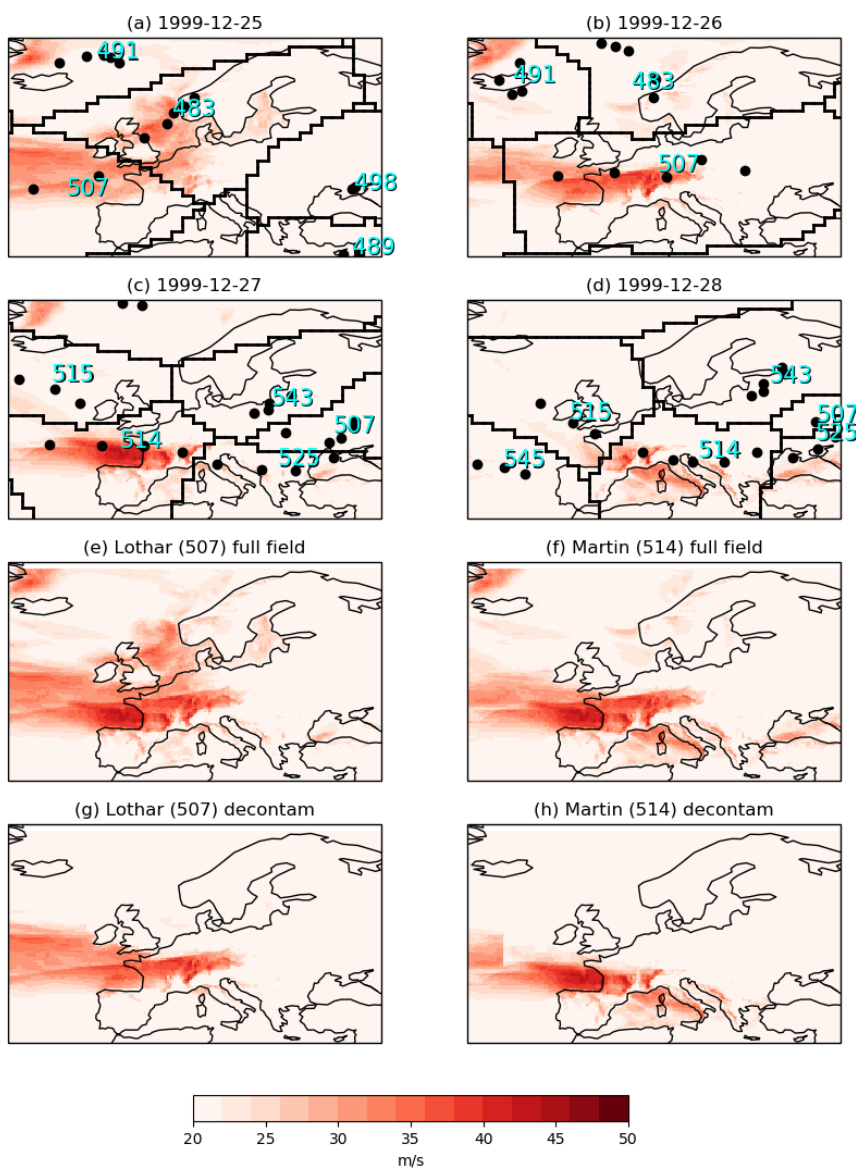
Figure 2. Storm separation method: panels (a–d) show the daily maximum gust fields from ERA5 for 25–28 December 1999, with the 6-hourly track points of each storm identified in the domain on that day (the cyan number gives the track identification number). The thick black lines mark the shape of the mask used for each track on each day; for example, the footprint of Lothar (track 507) is made by taking the maximum of the gusts in the marked areas around track 507 (the rest of the gusts are set to missing data) for 25–27 December. The resulting footprint is shown in panel (g) , compared to taking the maximum gusts over the whole domain on the same days shown in panel (e) . Panels (f) and (h) are the same for storm Martin (track